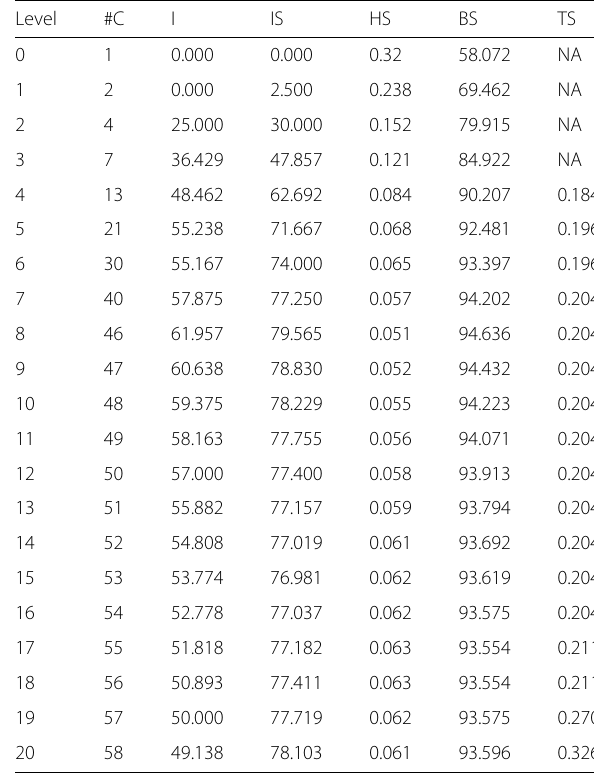
Table 6 Average values of the internal clustering evaluation metrics per tree level after the application of the binary tree construction algorithm on the NYTimes dataset